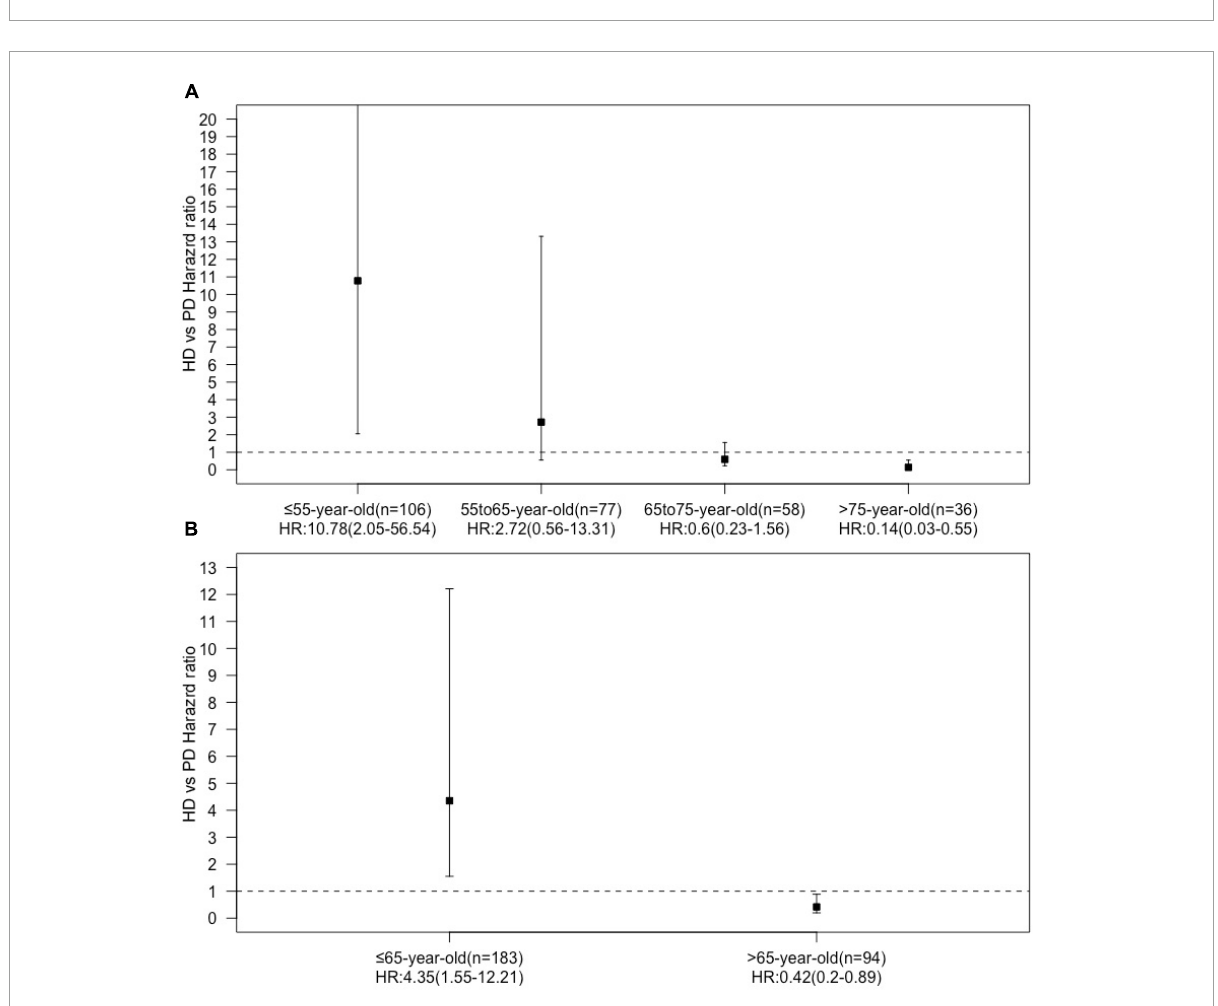
FIGURE3 Hazard ration dialysis methods (HD vs. PD) in age subgroups [ (A) four age subgroups, (B) two age subgroups].